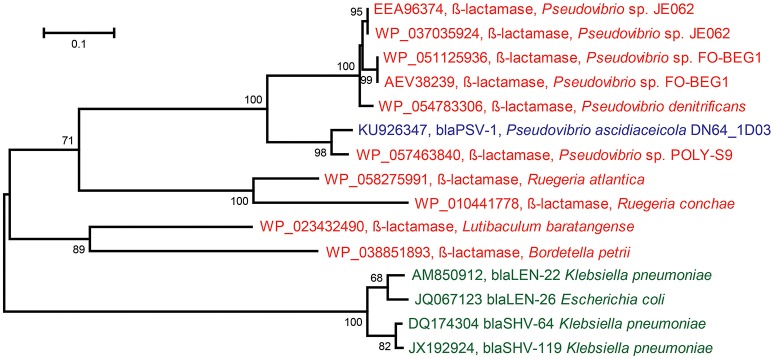
Maximum Likelihood Tree based on protein sequences of: the novel ß-lactamase (blaPSV-1) discovered in Pseudovibrio ascidiaceicola DN64_1D03 (blue), the closest homologs of the novel ß-lactamase in the NCBI non-redundant protein sequences database (red), and the closest homologs of the novel ß-lactamase in the CBMAR database (green) (the two closest homologs were picked for each of the two closest families: blaLEN and blaSHV). In this figure, only the proteins in green and the novel ß-lactamase (blaPSV-1) have demonstrated functionality. The tree was constructed in MEGA using 1000 iterations of bootstrapping. Bootstrap values <50 are not shown. The horizontal bar indicates the number of substitutions per site.